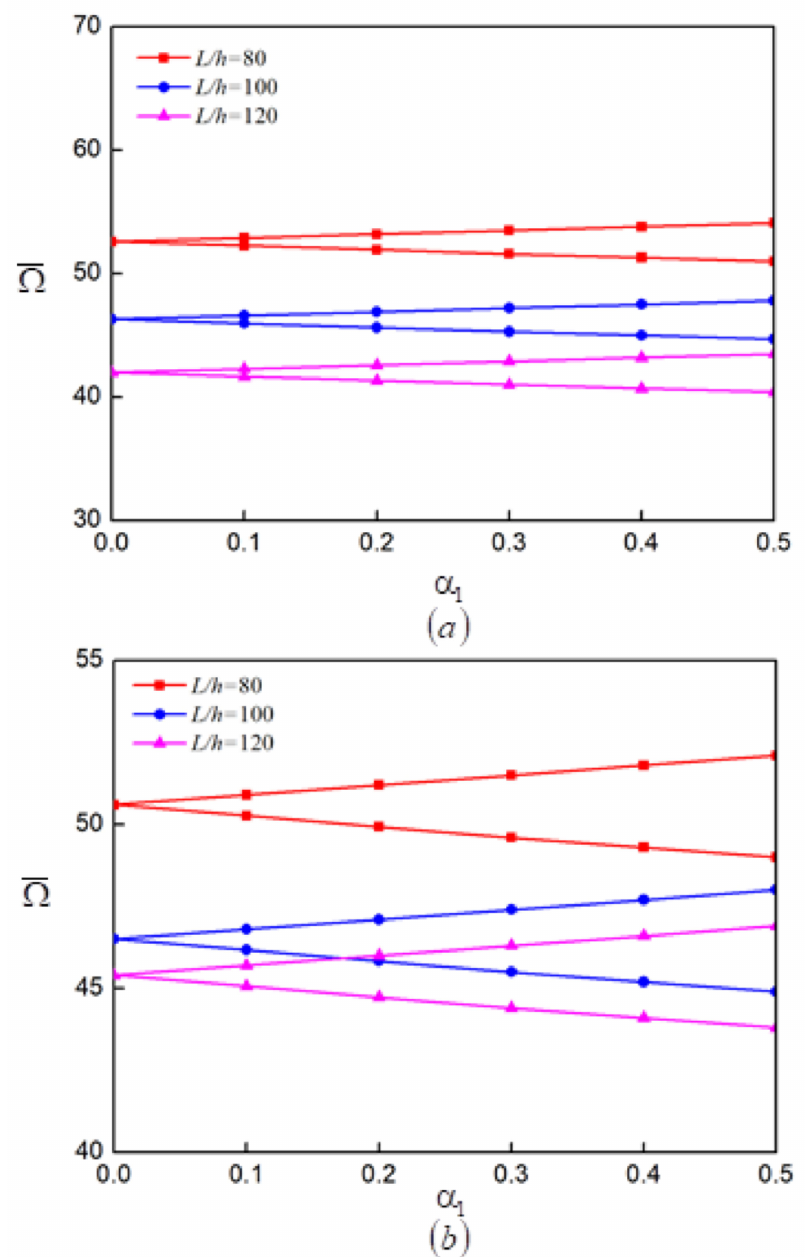
Figure 15. The dynamic unstable regions of the CFRP laminated cylindrical shell with different L / h : ( a ) the first mode, and ( b ) the second